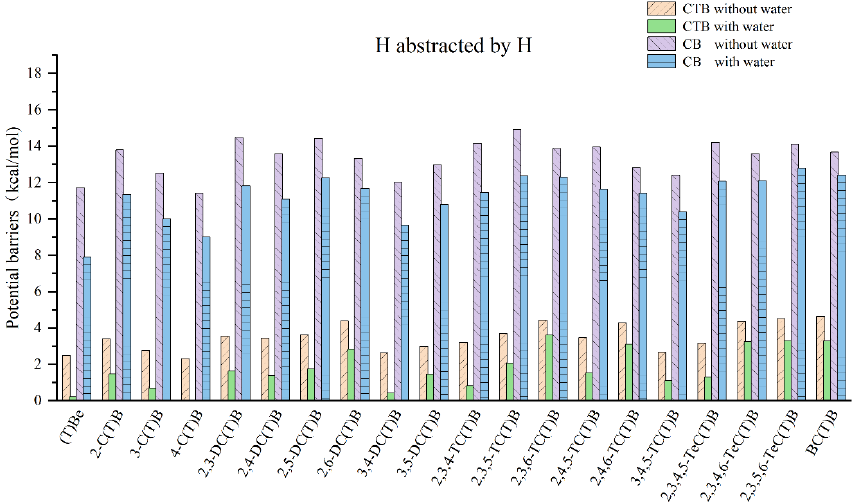
Figure 5. Histograms of potential barriers Δ E (in kcal mol − 1 , including ZPE correction) of the H abstraction from CTBs and CBs by H atom in hydrated and non ‐ hydrated cases. For comparison, Δ E of the H abstraction from CBs in hydrated and non ‐ hydrated cases are provided by References [36,38], respectively.